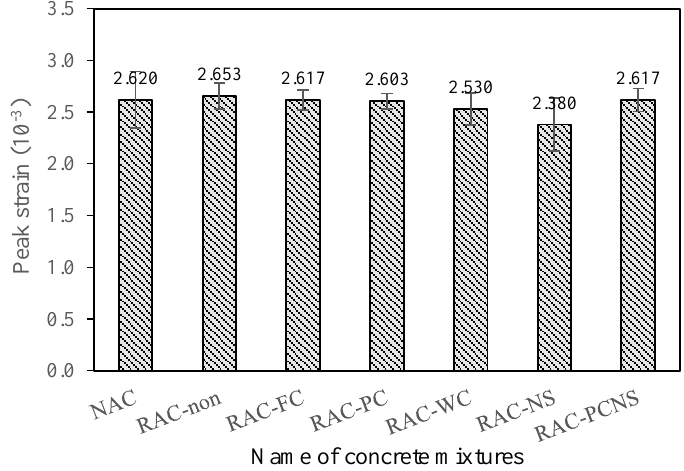
Figure 8. Peak strain of hardened concretes.